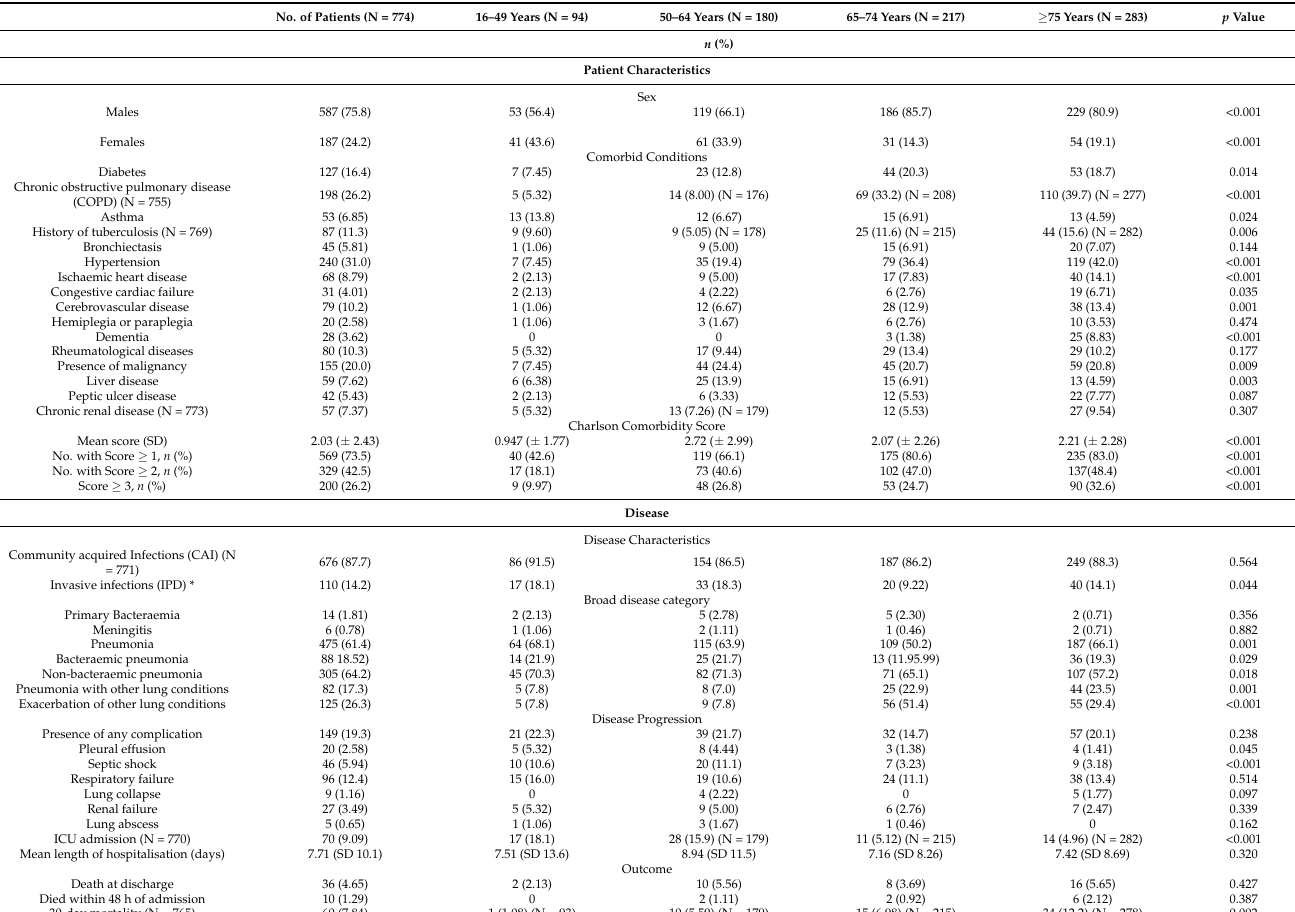
Table 1. Age stratified patient and disease characteristics ( p -values attained by Fisher’s exact test or Chi-square for categorical variables and on-way ANOVA for continuous